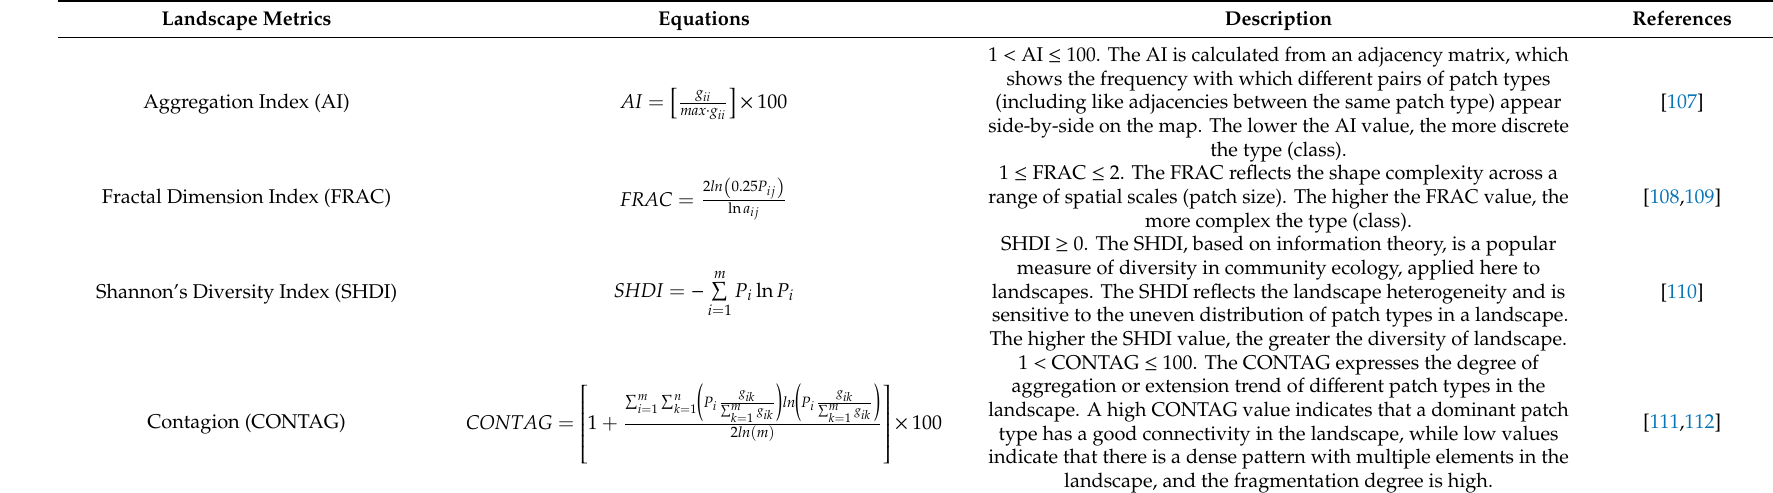
Table A3. The criteria of landscape spatial pattern for the potential suitable distribution